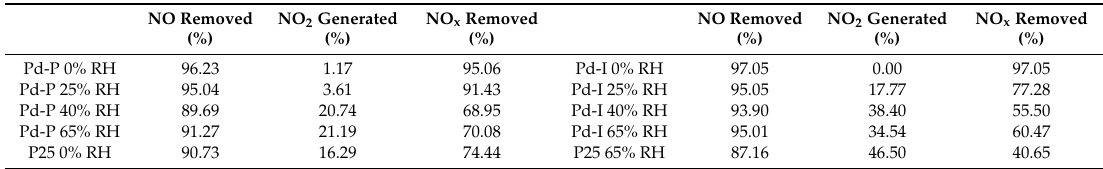
Table 3. Percentages of NO removed, NO 2 generated, and NO x removed for each of the tested photocatalyst samples for 5 h of UV-vis irradiation. RH stands for relative